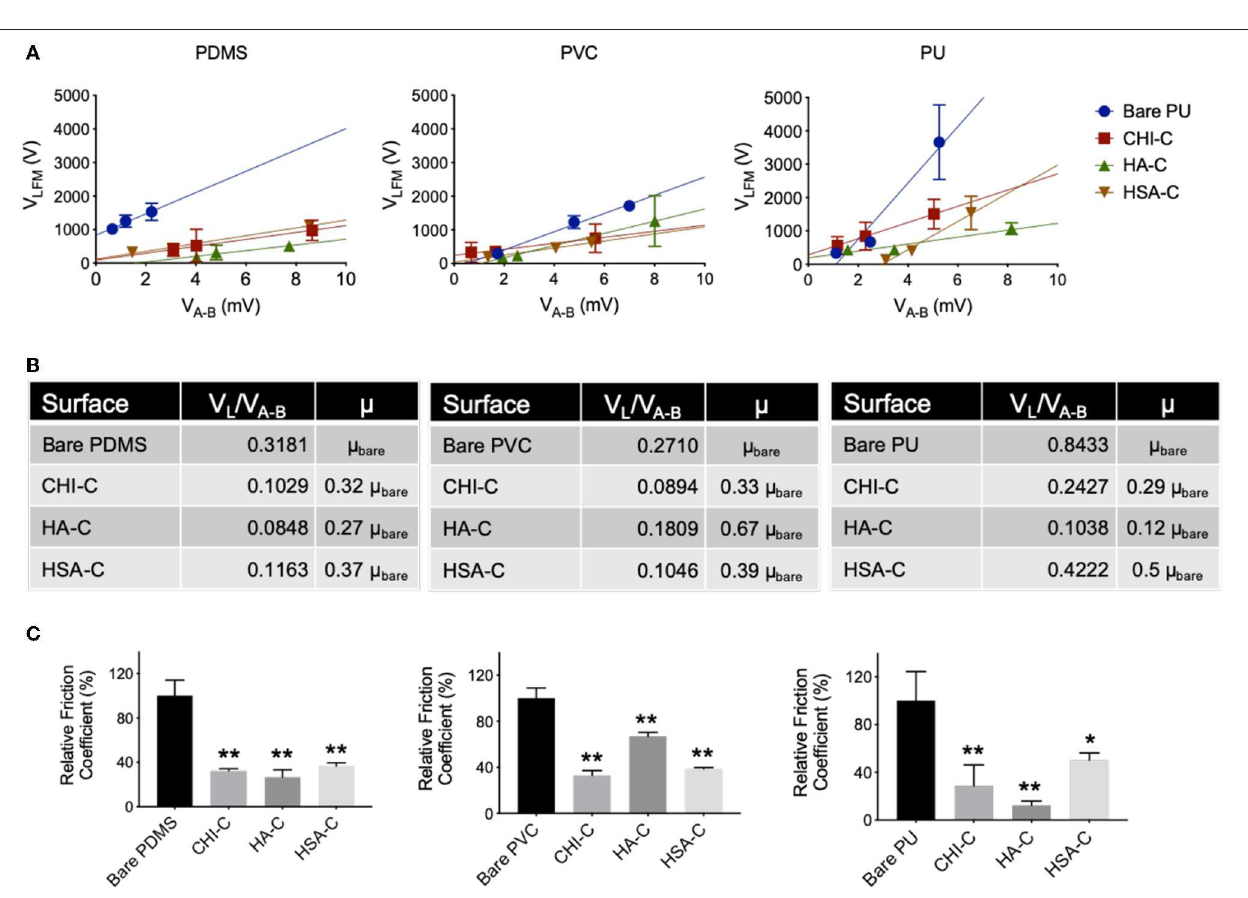
FIGURE 4 | Friction coefficient of PDMS, PVC, and PU substrates after modification with catechol-conjugated hydrogels CHI-C, HA-C, and HSA-C. (A) Lateral voltage (V A − B ) vs. normal voltage (V LFM ) of unmodified and coated substrates ( n = 3). (B) Friction coefficient (V L /V A − B ) and relative friction coefficient ( µ ) of coated substrates compared to bare surface. (C) The percentage of relative friction coefficient of coated substrates compared to unmodified substrates ( n = 3, * p < 0.05 and ** p < 0.01 vs.